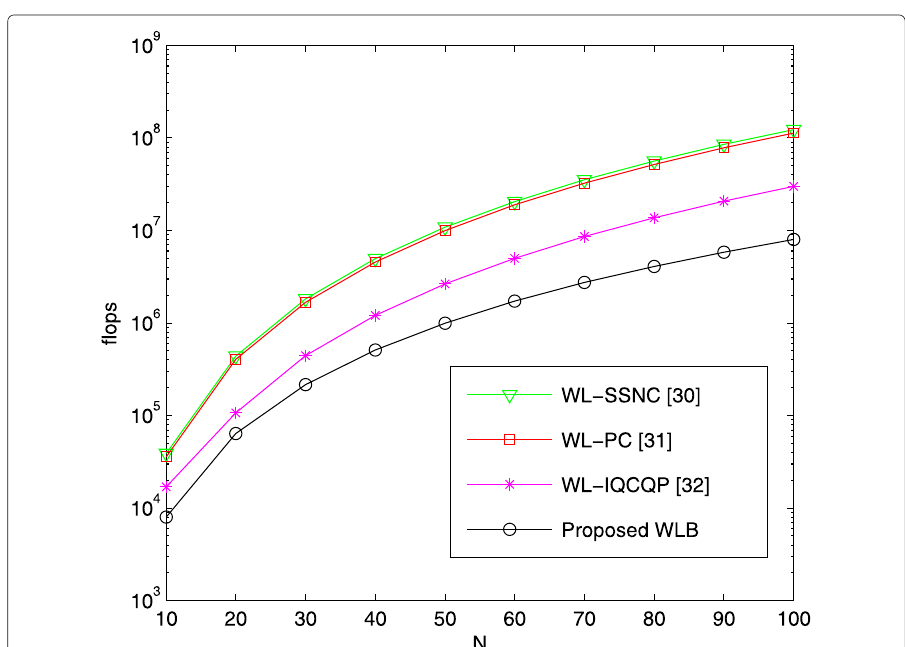
Fig. 1 Comparison of computational complexity. Flops curves versus the number of antennas